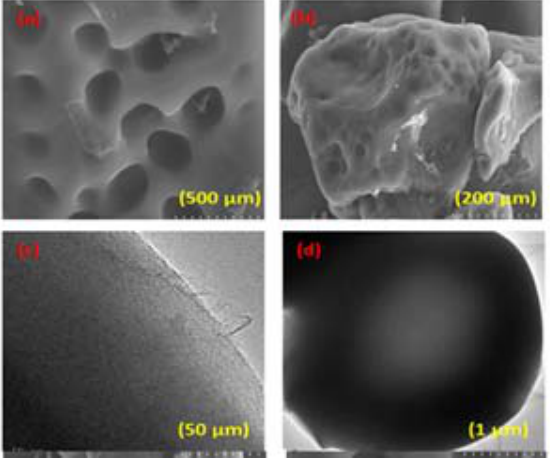
Figure 2. ( a , b ) SEM images of the starch-based AC and ( c , d ) TEM images of starch-based AC.